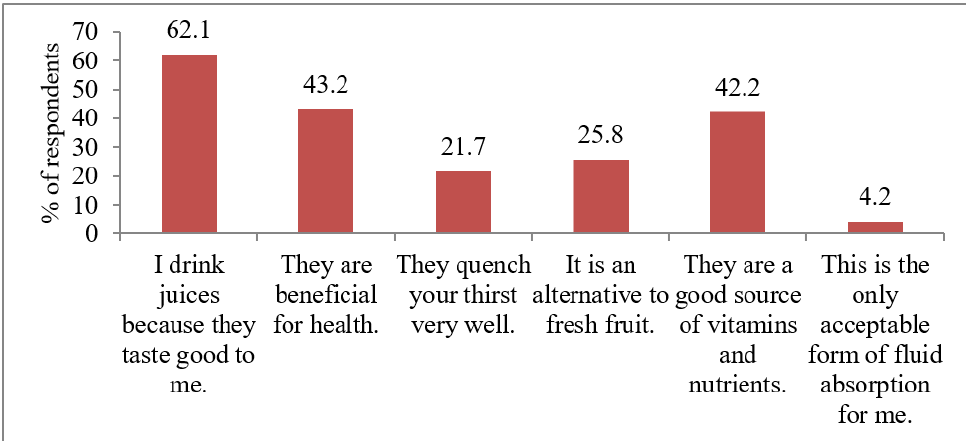
Figure 3. Reasons why respondents choose citrus juices.